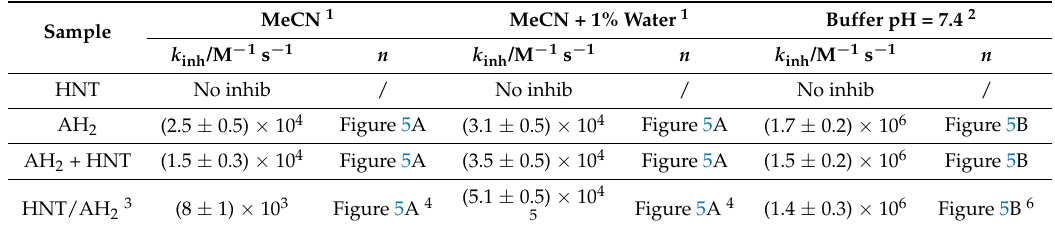
Table 2. Antioxidant activity: rate constant for the reaction with ROO • radicals, k inh , measured in inhibited autoxidation experiments at 303 K (mean ± SD, N = 3). The number of radicals trapped by each antioxidant molecule, n , obtained from the same experiments, is shown in Figure 5 and reported numerically in the supporting